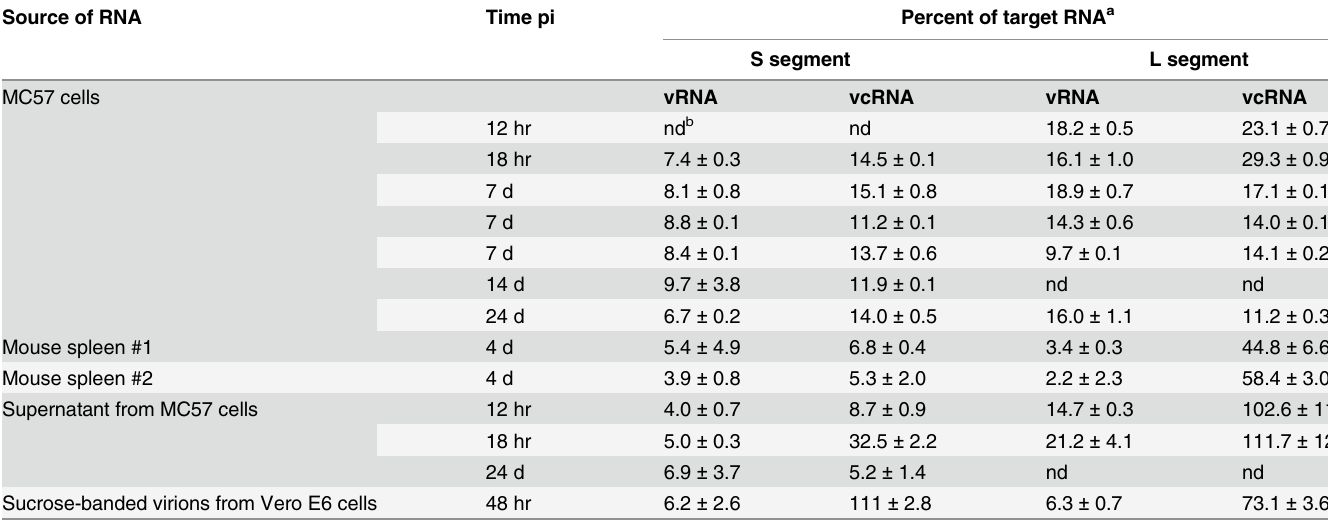
a For each RNA species, the numerical values represent the mean copy number ± standard deviation obtained via QRT-PCR in the absence of an LCMV segment-speci fi c primer during the RT step divided by the copy number obtained when the segment-speci fi c primer was used during RT. Each value was multiplied by 100 to convert to percentage.